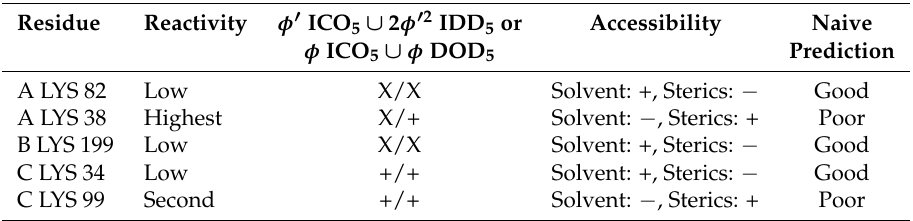
Table 5. A comparison of the reactivity of the 5 solvent exposed lysine residues of CPMV [17] and the geometric restrictions imposed by the point arrays. An X indicates that the point array is unlikely to permit changes at this location and a + indicates no specific geometric restriction. We also indicate our naive expectation of capsid reactivity based on good solvent accessibility (+) and lack of steric hindrance (–). Both point arrays indicate that A LYS 82 and B LYS 199 should have low reactivity as there is a point array element nearly atop each, implying that the site is a key structural feature, similar to the loop protrusions of MS2. Both point arrays also agree that C LYS 99 should have no restrictions on reactivity. While φ (cid:48) ICO 5 ∪ 2 φ (cid:48) 2 IDD 5 is the best fit point array, it indicates that the most